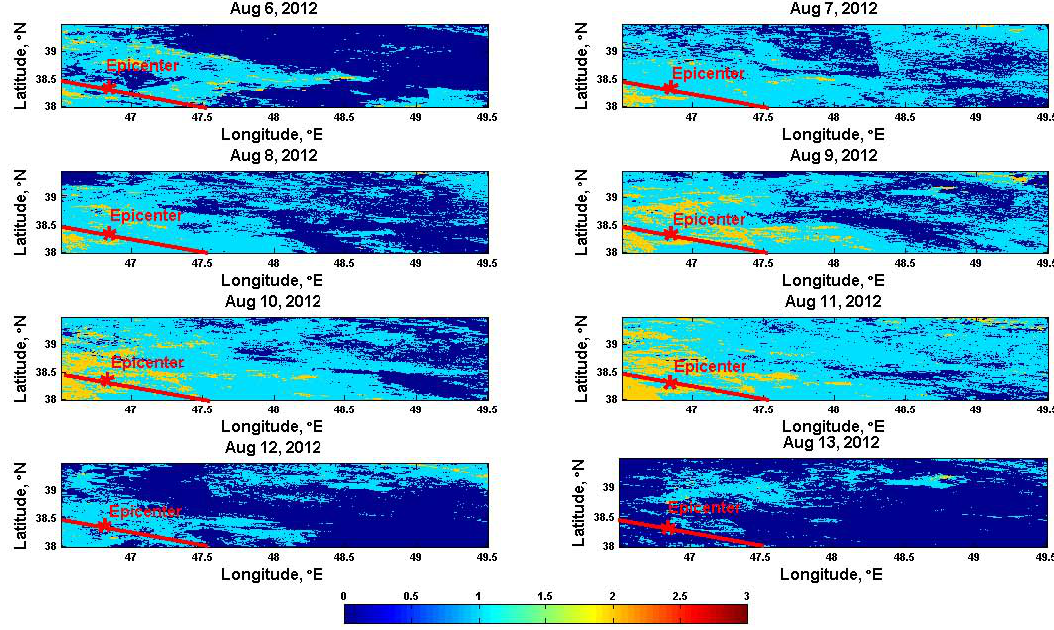
Fig. 3. Night-time land surface temperature images obtained from the RST (robust satellite-based thermal infrared) method during the period of 6 to 13 August 2012. Red asterisk and curve represent the epicenter and fault line,